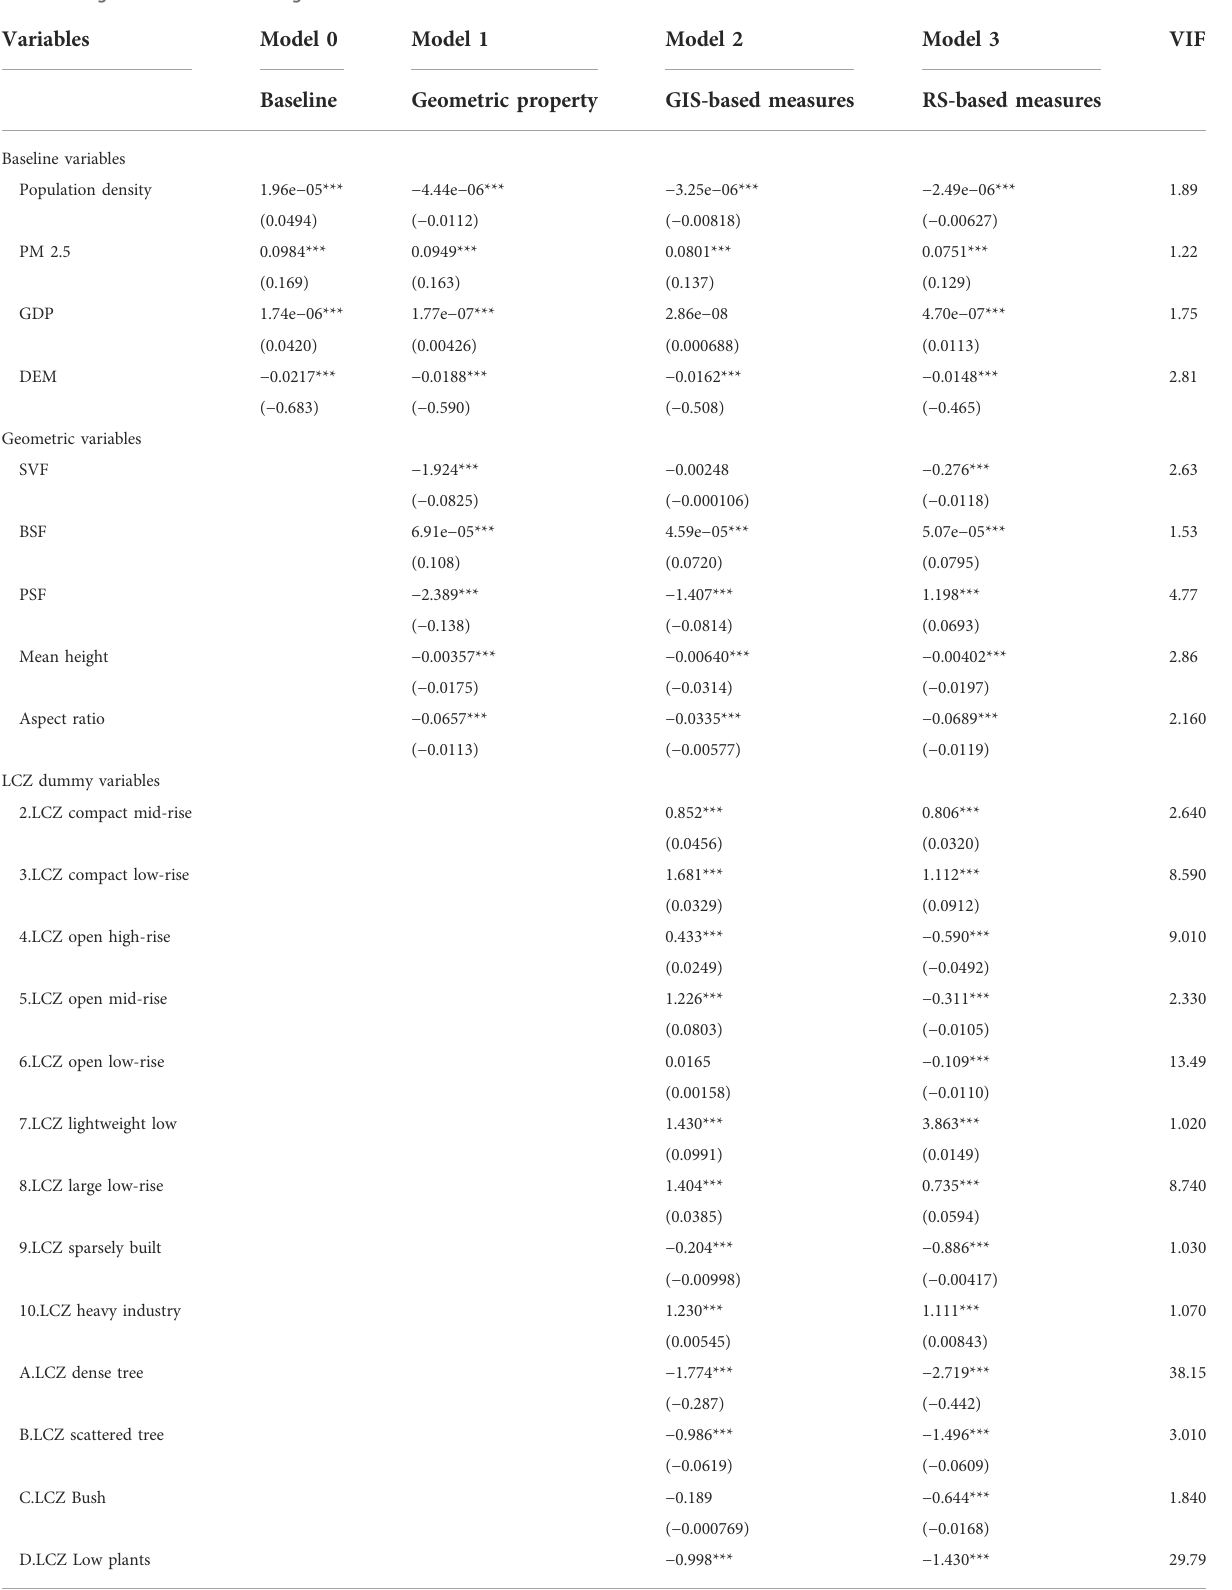
TABLE 4 Regression results and